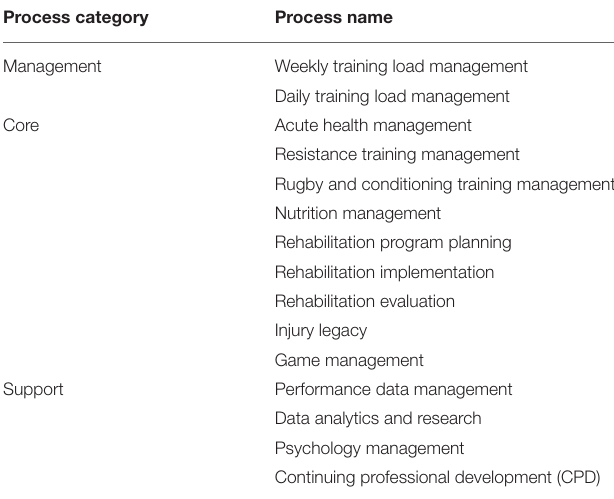
TABLE 2 | High-level processes in the HPU (grouped by the three process categories). Process